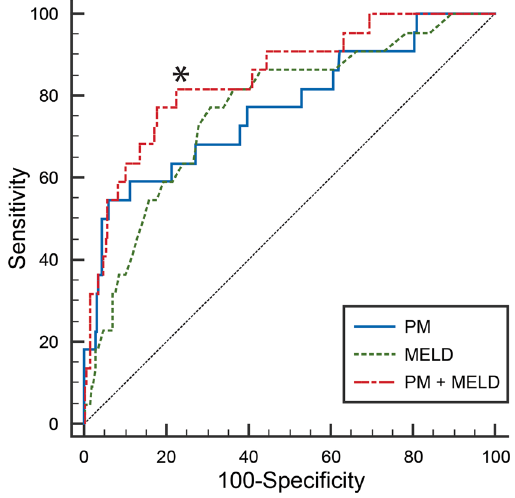
Figure 3. ROC curves of the prediction models. Three ROC curves were built from the propensity scores of prediction models built with performance measures (PM model), MELD score (MELD model) or both (PM + MELD model), respectively. Addition of performance measurement parameters to the MELD model increased the diagnostic specificity of prediction model from 77% to 84%. The combined model has a significantly larger area under ROC curve compared to the PM model. * P = 0.007 vs PM model. Abbreviations: ROC = receiver operating characteristic; PM = performance measurement; MELD = model for end-stage liver